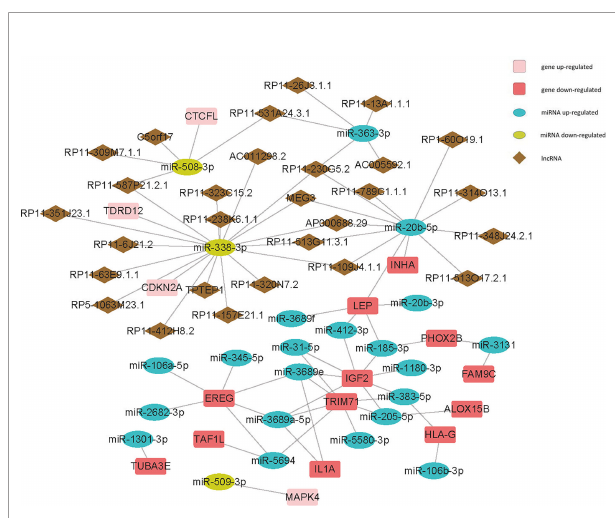
FIGURE 6 | Competing endogenous RNA (ceRNA) network of cell-cycle- relatedDEGs - differentially expressed miRNAs - differentially expressed lncRNAs.